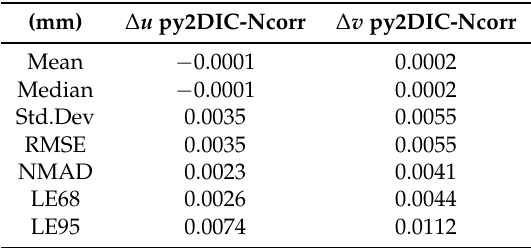
Figure 11. v displacements (mm) for the tensile test of GFRP sample obtained from DIC technique. ( a ) py2DIC raw results ( b ) py2DIC smoothed results using Gaussian filter ( c ) Ncorr results ( d ) Vic-2D results ( e ) DICe results [11]. Table 6. Comparison with Ncorr : statistical parameters of displacement